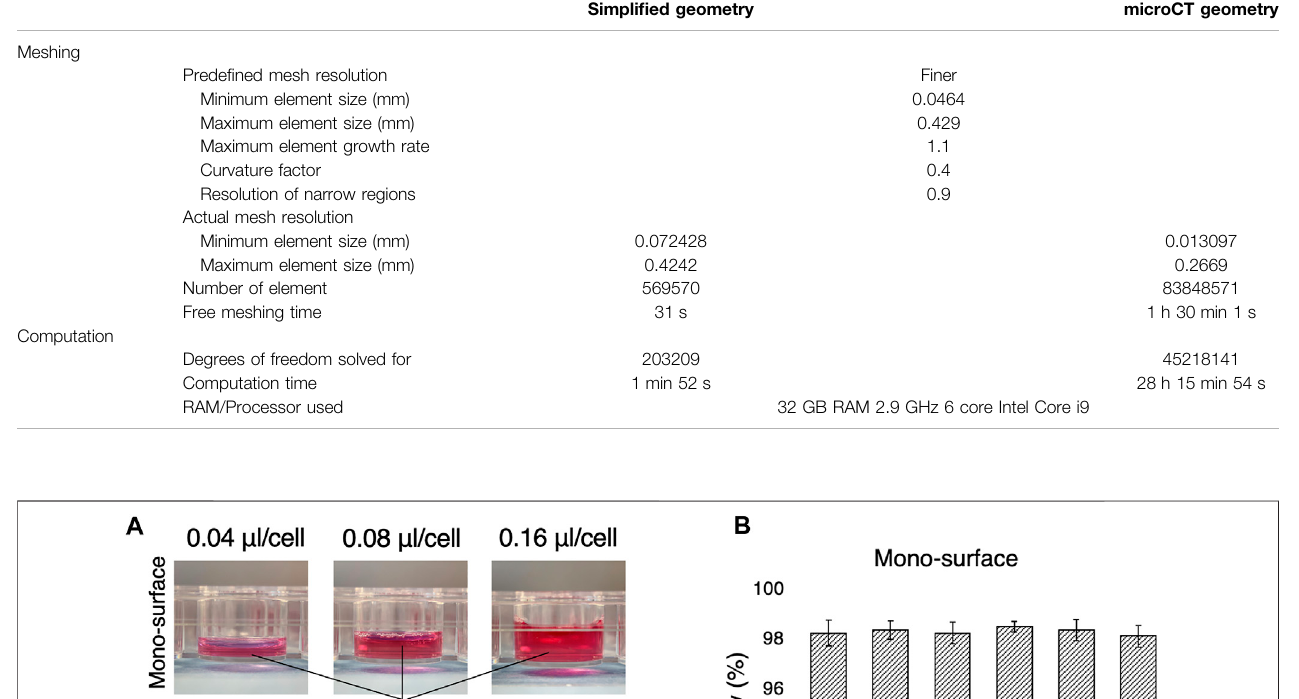
Frontiers in Bioengineering and Biotechnology |